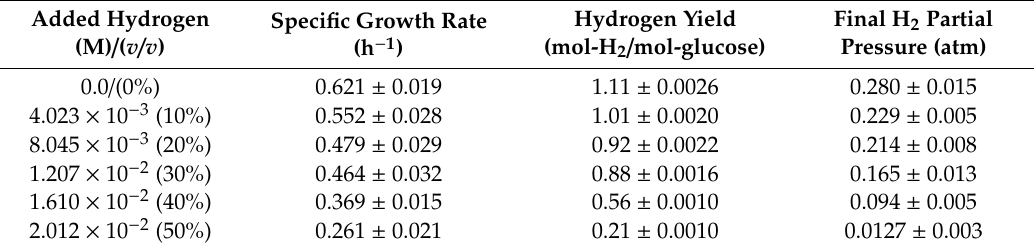
Table 2. E ff ects of added hydrogen on specific growth rate, hydrogen